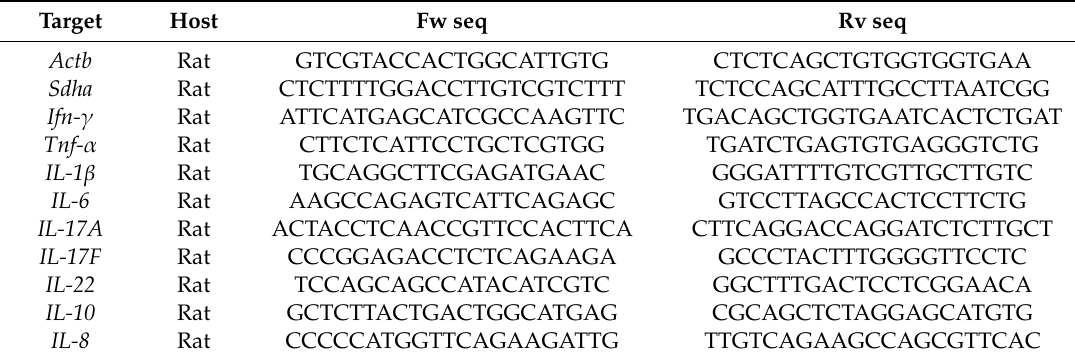
Table A1. Primer sequences used for this study. ACTB and SDHA were used as housekeeping